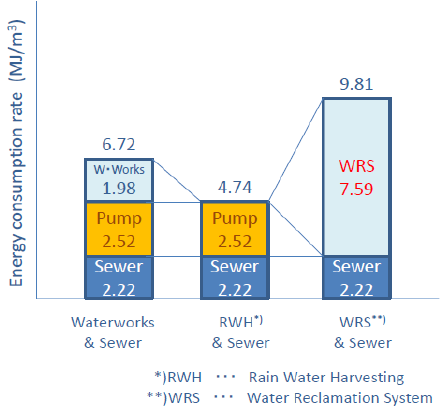
Figure 4. Energy consumption rates of water systems for non-residential buildings with booster pumps (MJ/m 3